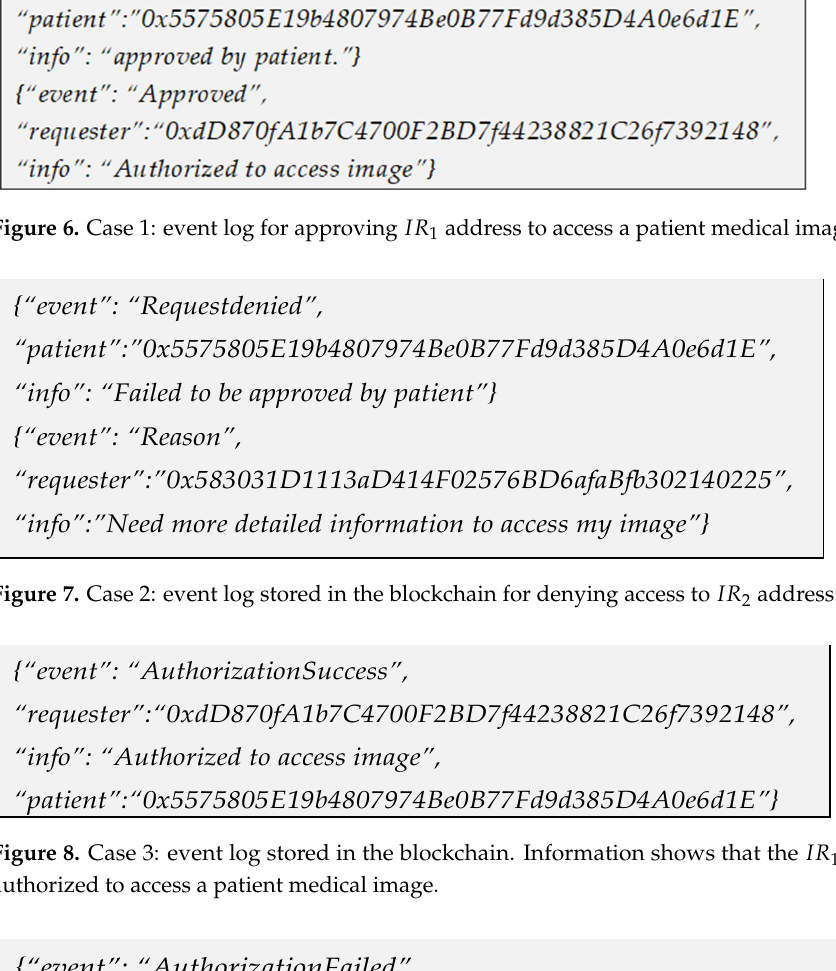
Figure 9. Case 4: event log where the